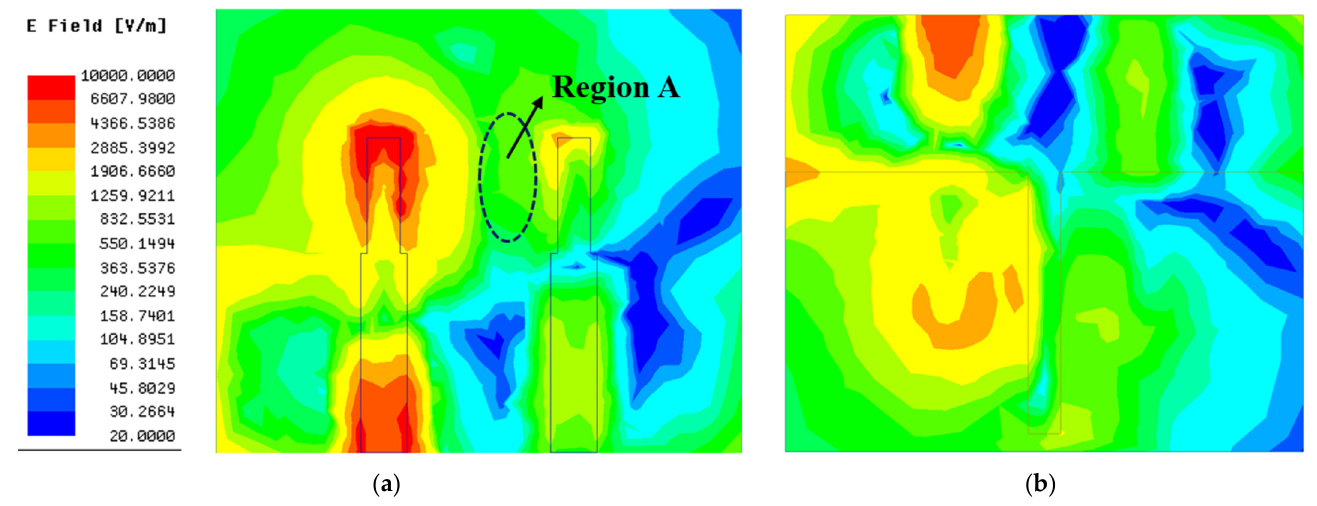
Figure 8. The distribution of the surface electric field of antenna 2: ( a ) top surface; ( b ) bottom surface.